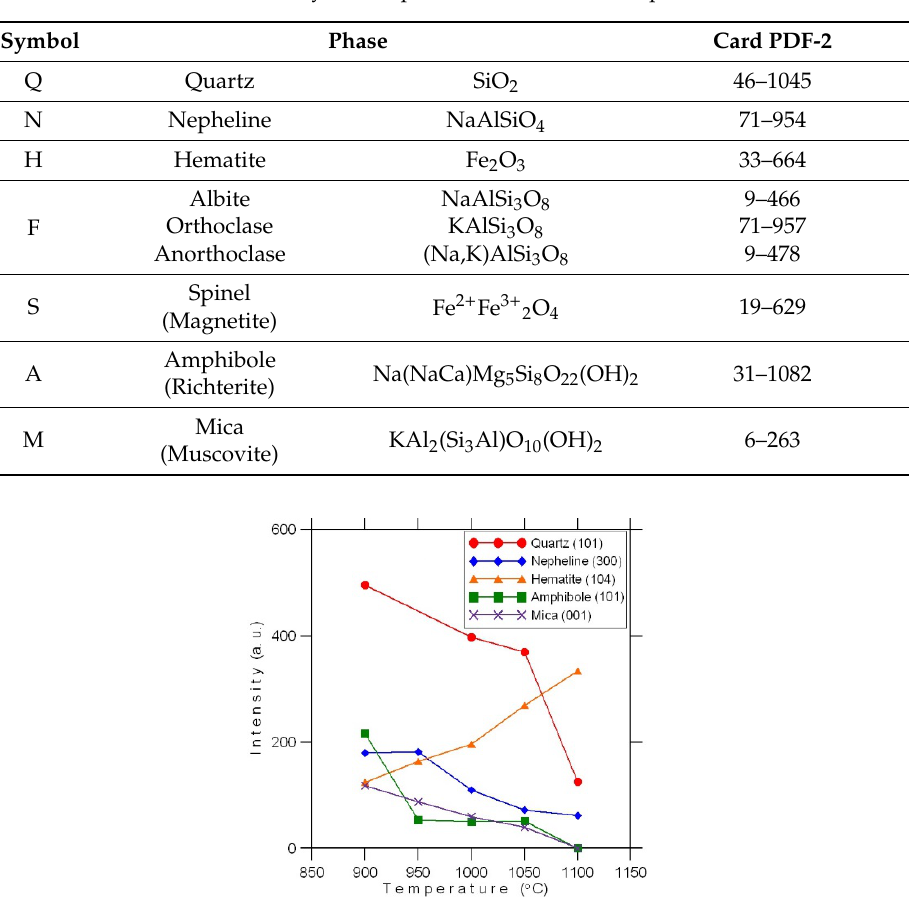
Figure 2. The main crystalline components of the ceramic samples at different temperatures.